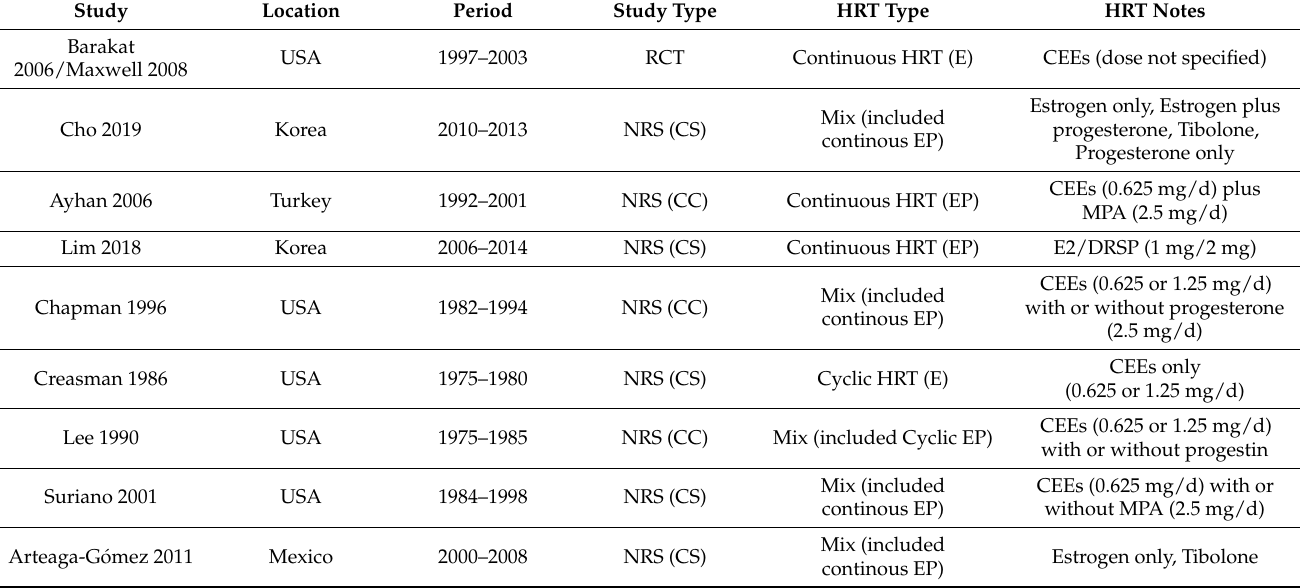
Table 1. Description of the included